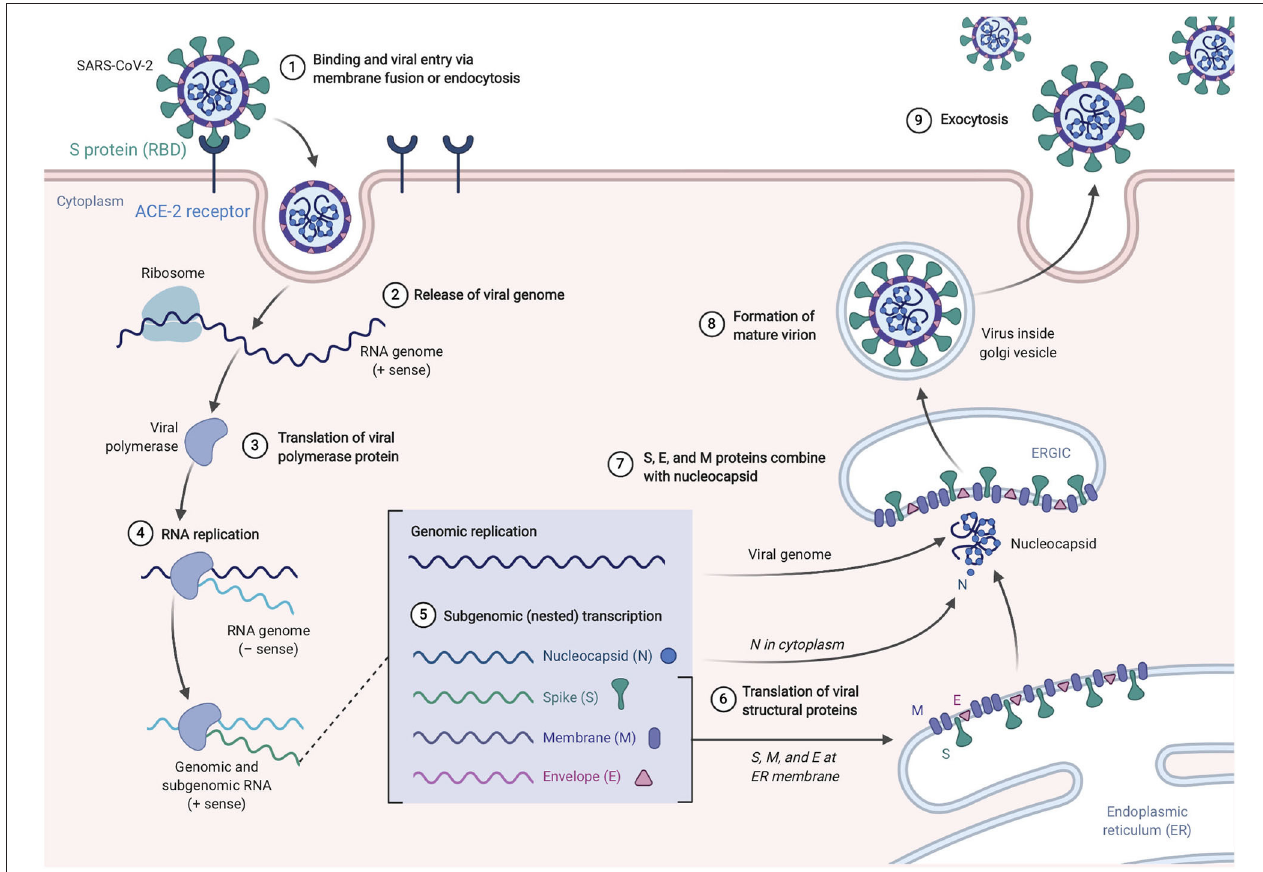
FIGURE 3 | SARS-Cov-2 life cycle. The virus enters and replicates in cells that express ACE2 such as lung epithelia, myocardial, renal, GI tract, and hepatic cells. The mature virions are released from the primary host cells via exocytosis and infect new target cells. Figure from